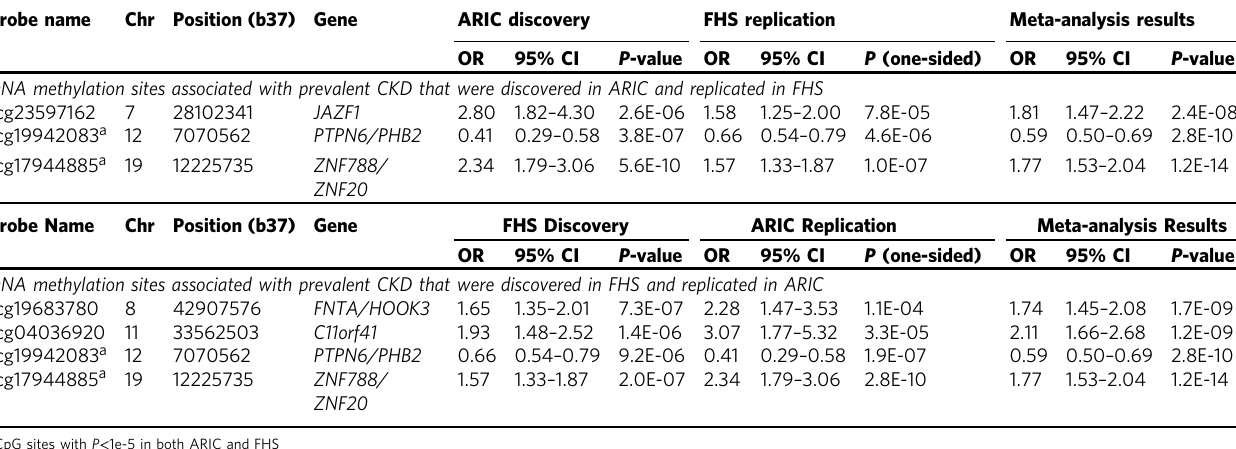
Table 3 Validated DNA methylation sites associated with prevalent CKD. DNA methylation sites associated with CKD ( P < 1e-5) in ARIC ( N cases = 75, N controls = 2189) and FHS ( N cases = 298, N controls = 2297), that were successfully replicated in the other cohort after correction for multiple testing ( P Bonferroni < 2.0e-3) and attained epigenome-wide signi fi cance ( P meta < 1e-7) in a combined fi xed effects inverse-variance weighted meta-analysis of ARIC and FHS. The Bonferroni threshold was set at 2.0e-3 = 0.05/25, the number of unique CpG sites brought forward for replication in both ARIC and FHS